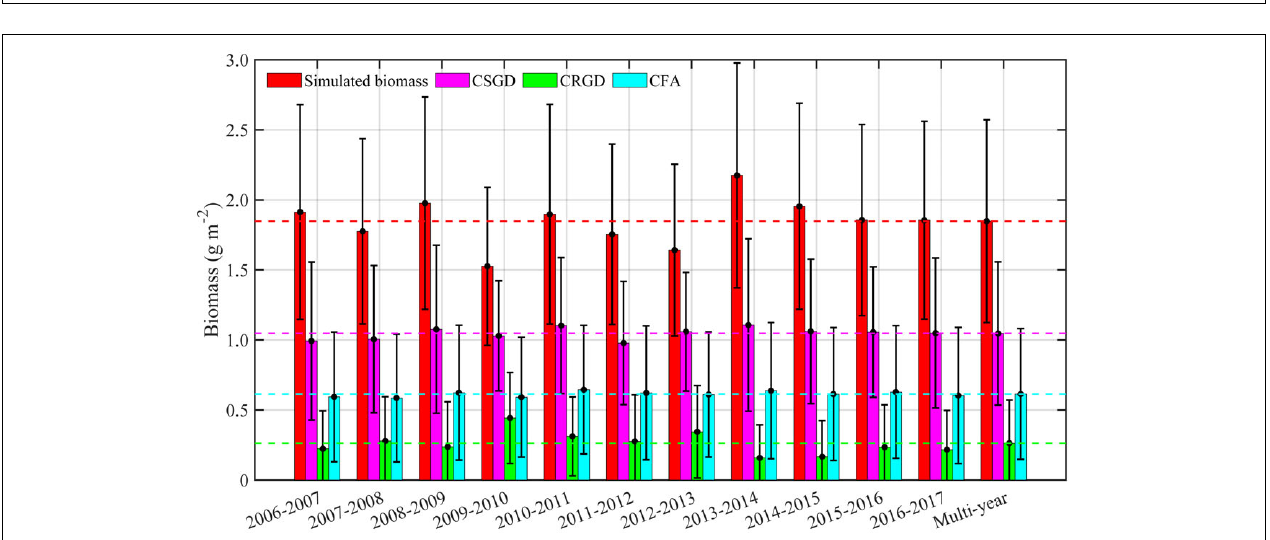
FIGURE 8 | Histogram of the annual and the multiyear average of regional mean simulated biomass, contributions from suitable growth days (CSGD), contributions from restricted growth days (CRGD), and contributions from food accumulation (CFA) from 2006 to 2017 for the Yesso scallop ( P. yessoensis ) in the Changhai sea area,